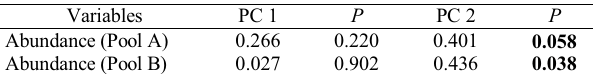
Table 2. Values of the Pearson correlations between the abun- dance of small-sized fish at each point along the ladder (Pools A and B) located near Itaipu Dam and the principal compo- nents that summarized the variables considered. ( P = prob- ability of type I